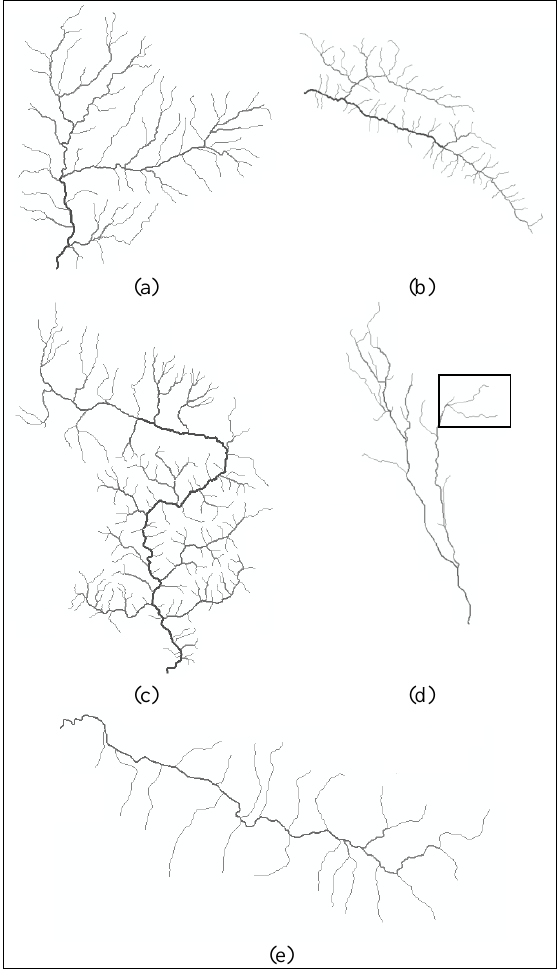
Figure 9. Sub-catchment from Russian river basin, (a), (b), (c), (d) and (e) from regions R 2 , R 3 , R 4 , R 5 , R 6